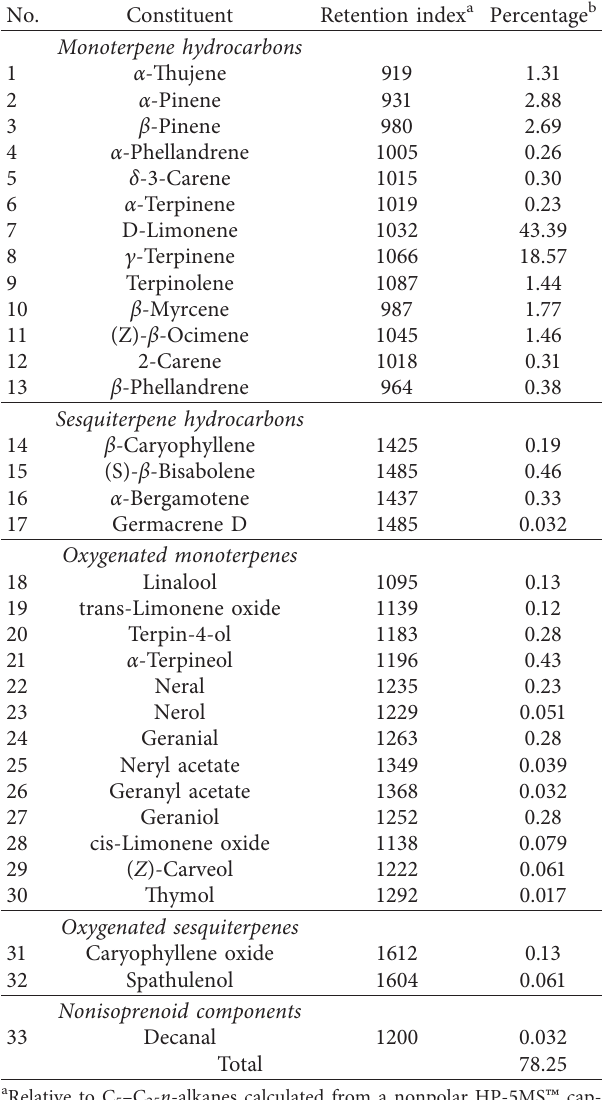
Table 1: Major components from the essential oil of fingered